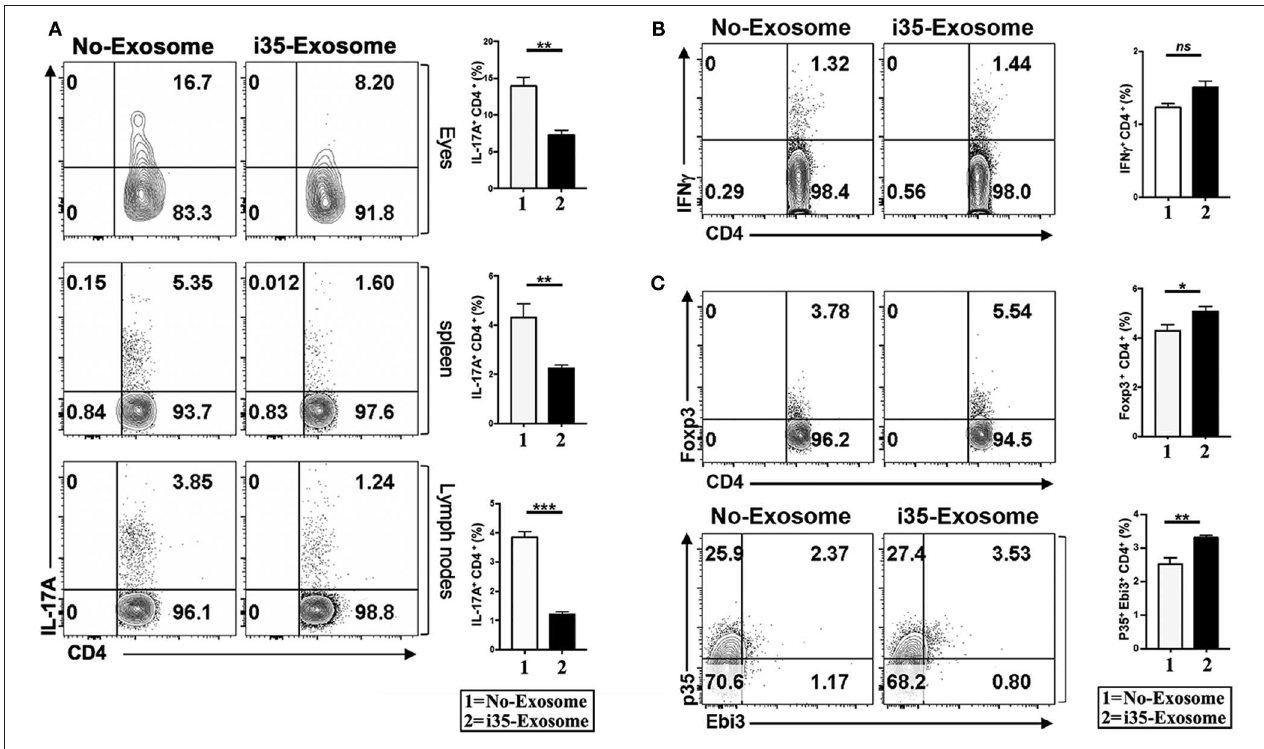
FIGURE 3 | Amelioration of uveitis in i35-Exosome-treated mice correlates with suppression of Th17 responses and expansion regulatory T cells. (A) Analysis of CD4 + lymphocytes in the eye, spleen, or lymph nodes of mice treated with PBS or i35-Exosomes by the intracellular cytokine assay ( n = 14 ). (B,C) Analysis of CD4 + T cells in the eye of mice treated with PBS or i35-Exosomes by the intracellular cytokine assay ( n = 14 ). Data are presented as mean ± SEM of three replicates. Results represent three independent studies. * p < 0.05, ** p < 0.01, *** p <